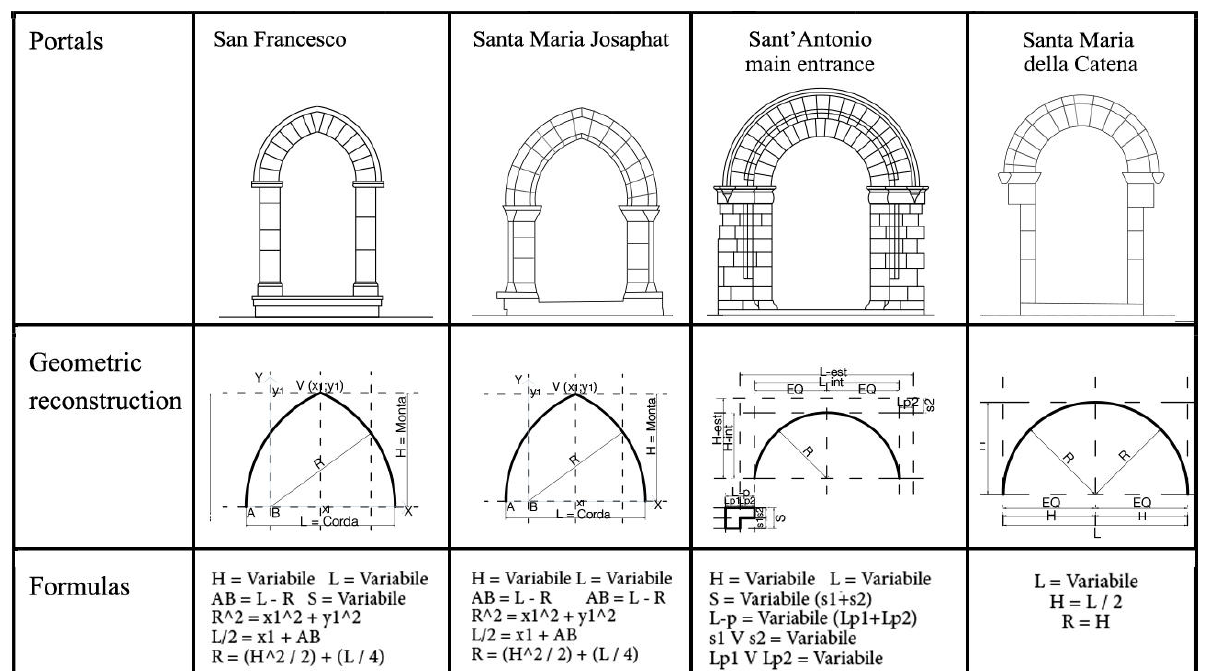
Figure 3. Geometrical and mathematical reconstruction of some studied portals.